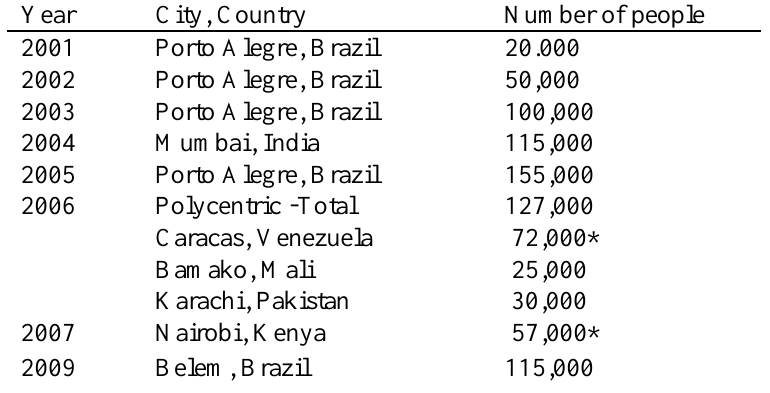
Table 1: Growth of the global WSF since its inception in 2001 to 2007 (total